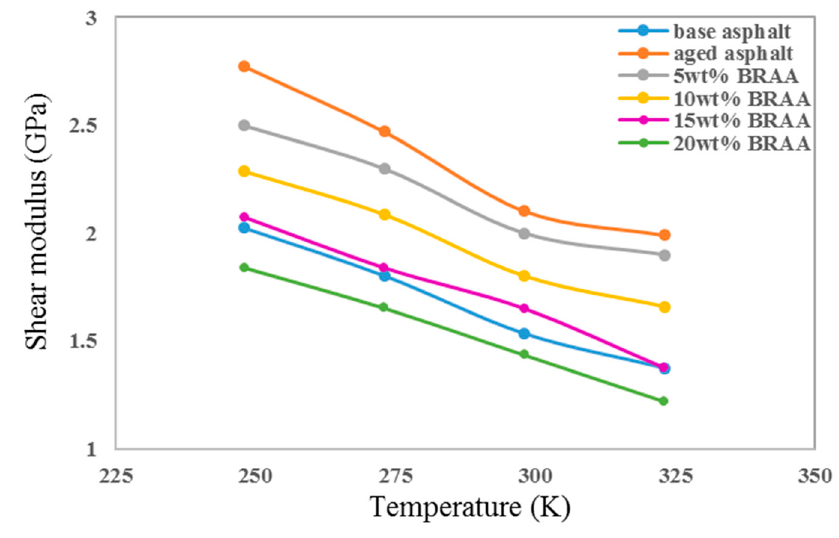
Figure 6. Shear moduli of asphalt systems at different temperatures.